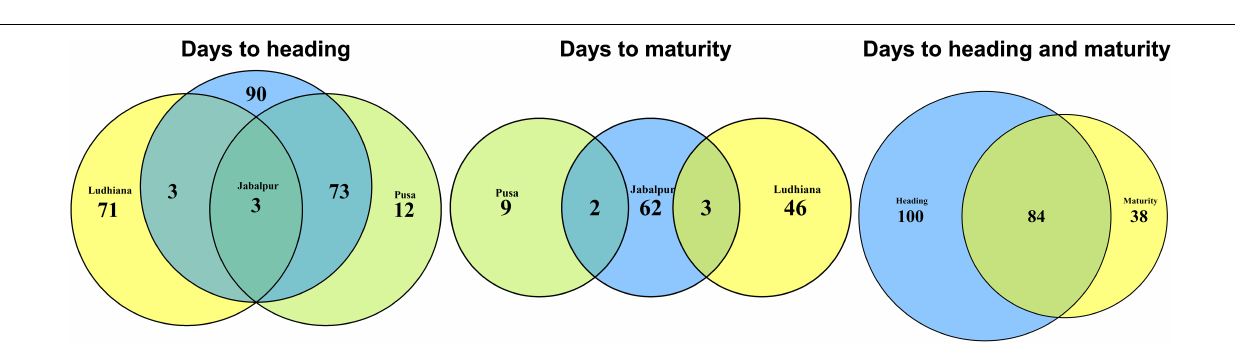
FIGURE 7 | Venn diagrams showing the markers significantly associated with days to heading (DH) and maturity (DM) in different sites and the overlapping number of markers across sites and